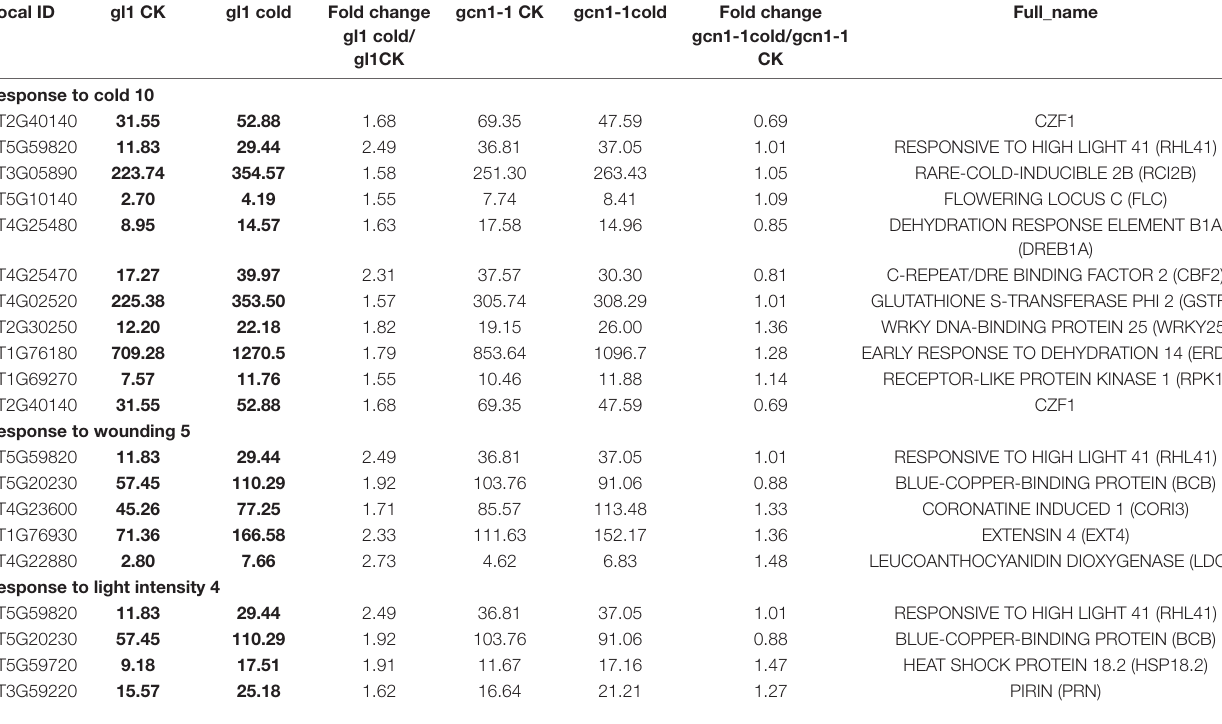
TABLE 2 | Partial classification data of Cold-ATGCN1 up-regulated genes at transcriptional levels. Local ID gl1